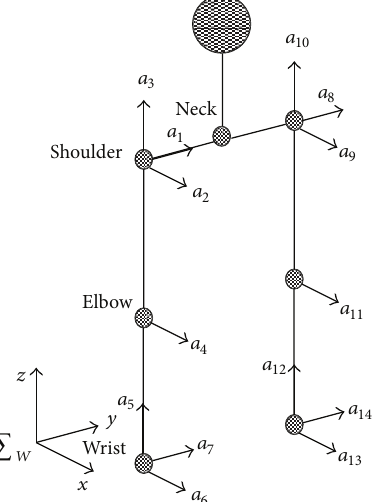
Figure 3: Model structures of the robot